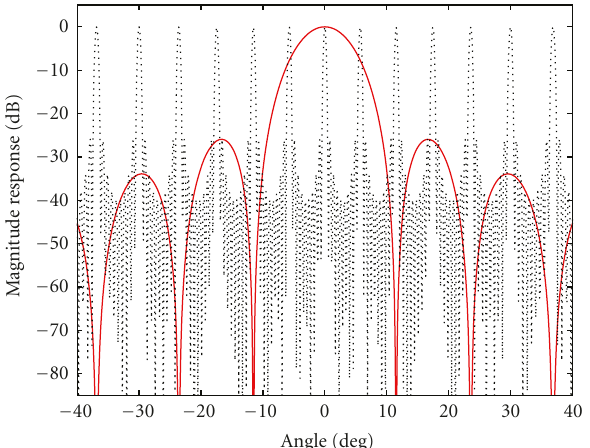
Figure 7: Grating lobes cancelled by the nulls of the subarray beam with M = 10 and L = 20 λ 0 / 2.